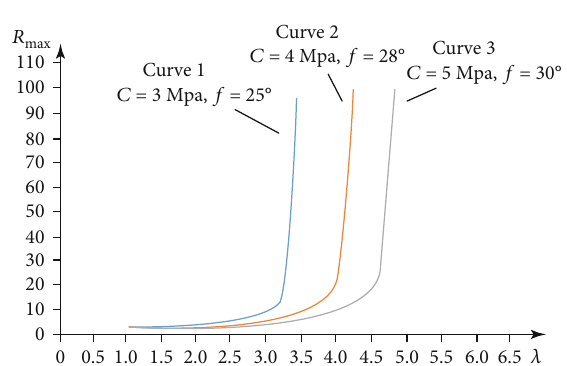
Figure 5: Butter fl y-shaped plastic